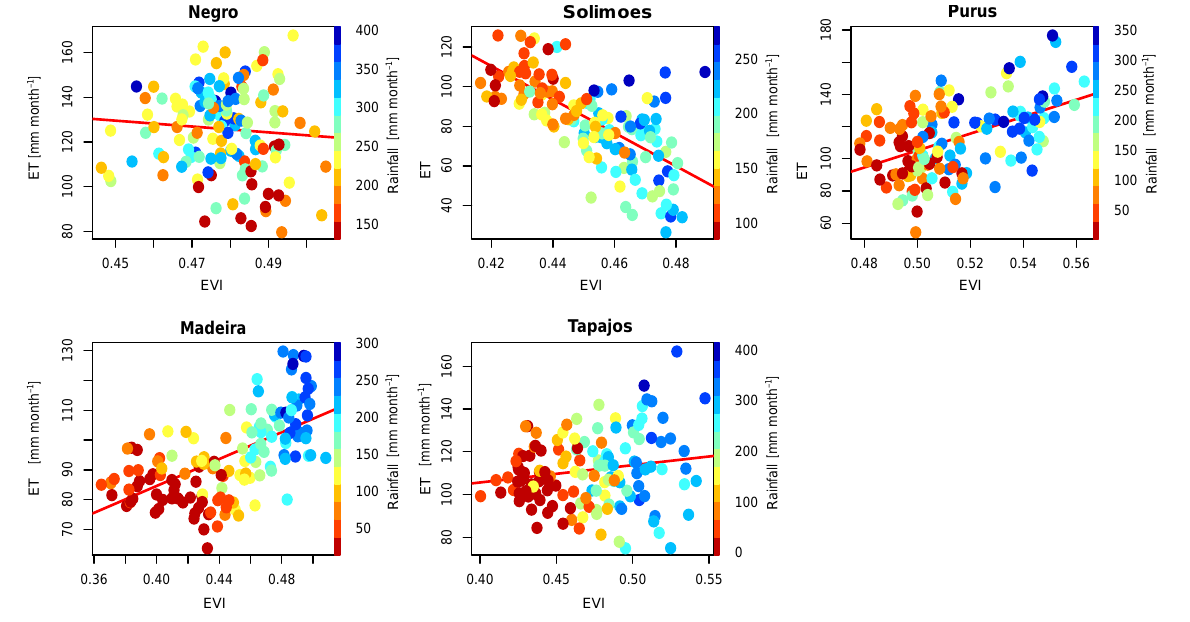
Figure 6. Relationship between monthly evapotranspiration (ET) and MODIS enhanced vegetation index (EVI) at each Amazon sub-basin using the data from 2001 to 2014. Colour gradient indicates the monthly rainfall value, from high (blue) to low (red). Negro